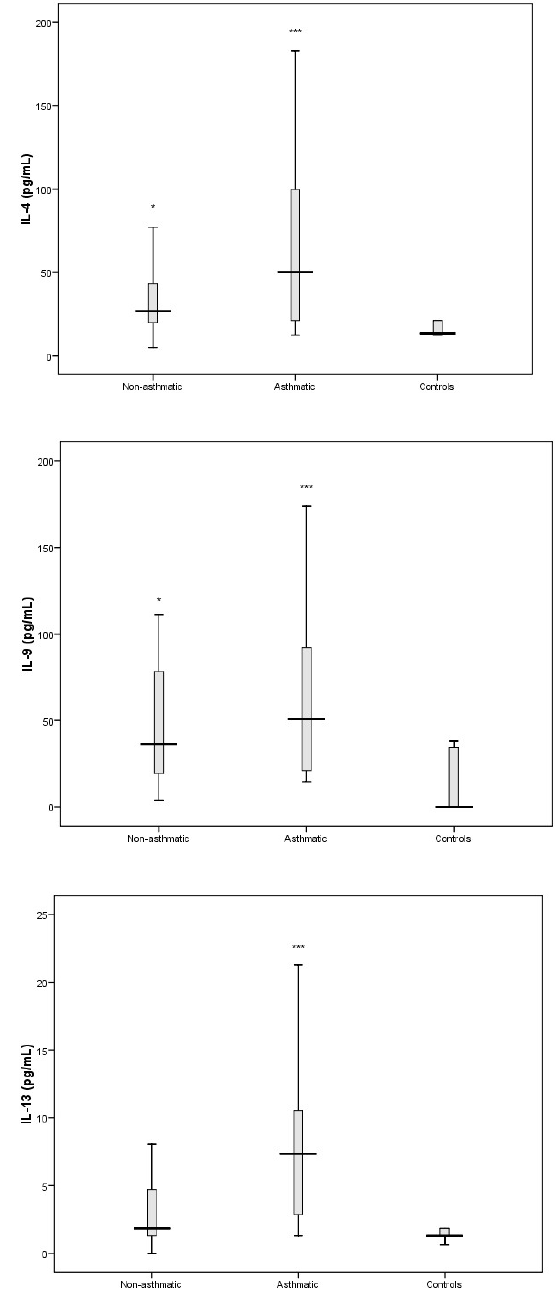
Figure 2. Levels of Th2 cytokines IL-4, IL-9, and IL-13 in nasal secretions of RV-C-infected asthmatics, RV-C-infected non-asthmatics, and healthy controls. * p < 0.05; *** p < 0.001.